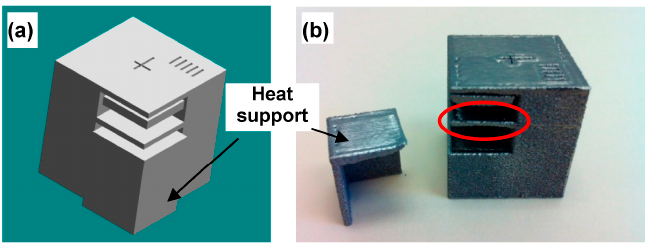
Figure 4. An example of ( a ) contact-free heat support in an overhang model and ( b ) the fabricated overhang without distortion (Red circle indicating the overhang area).